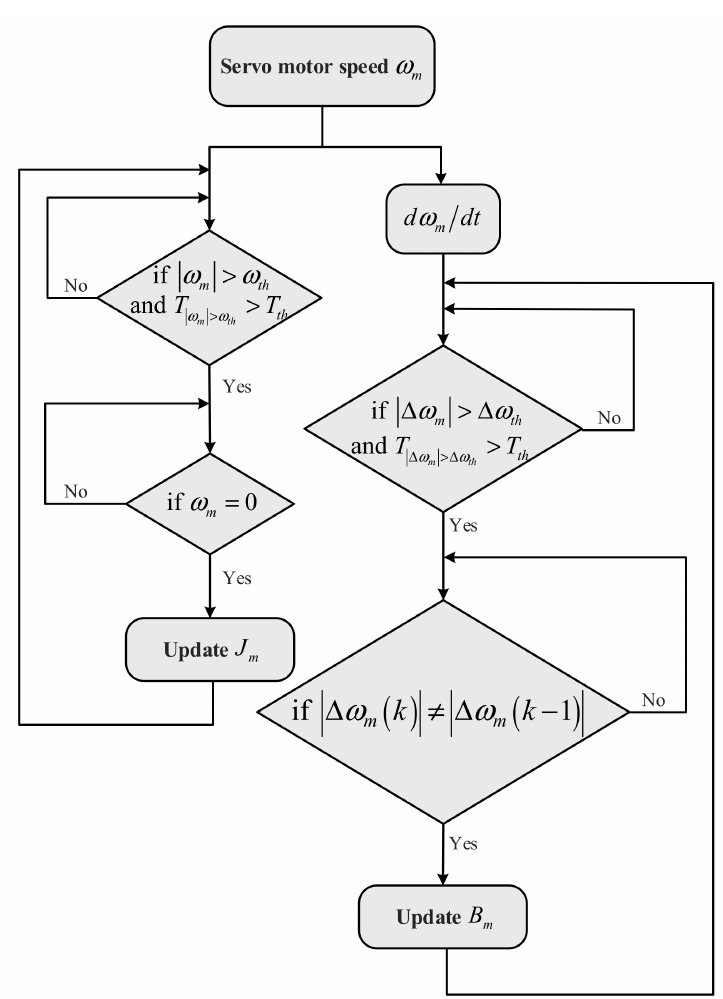
Figure 4. The flow chart of the proposed update